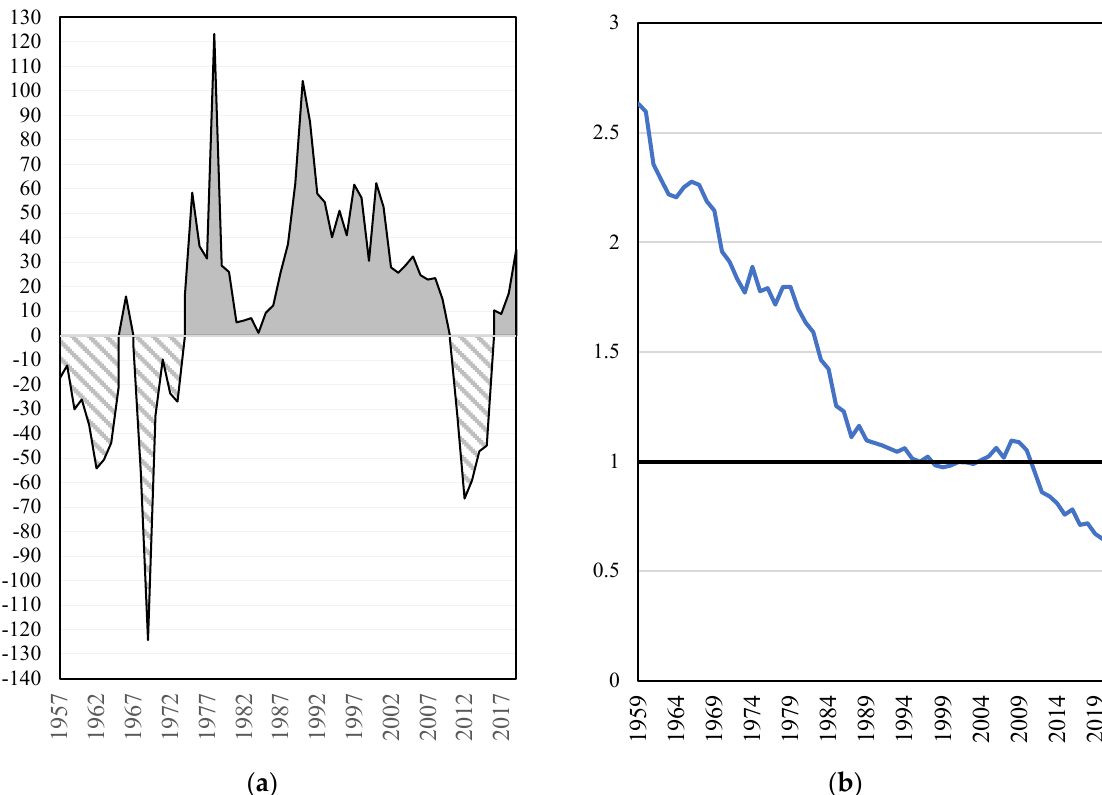
Figure 6. Net migration flow ( a , in thousands) and births over deaths ratio ( b ), 1957–2020, Greece. Source: ELSTAT and authors’ calculations.